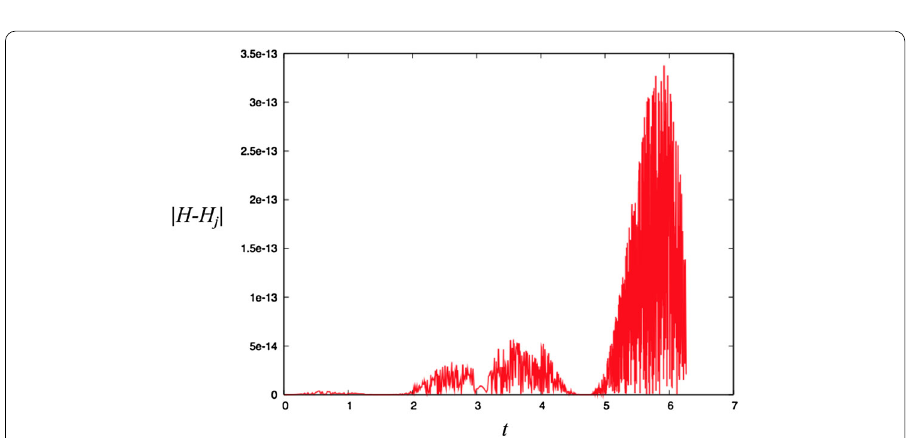
Fig. 16 Approximate solution with rectangle-rule variational integrator